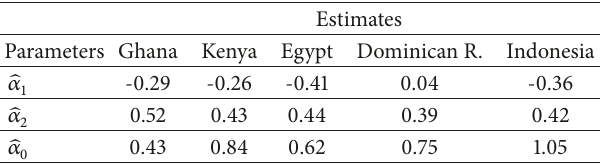
Table 3: Educational Attainment: Estimates for the non-interacting model.